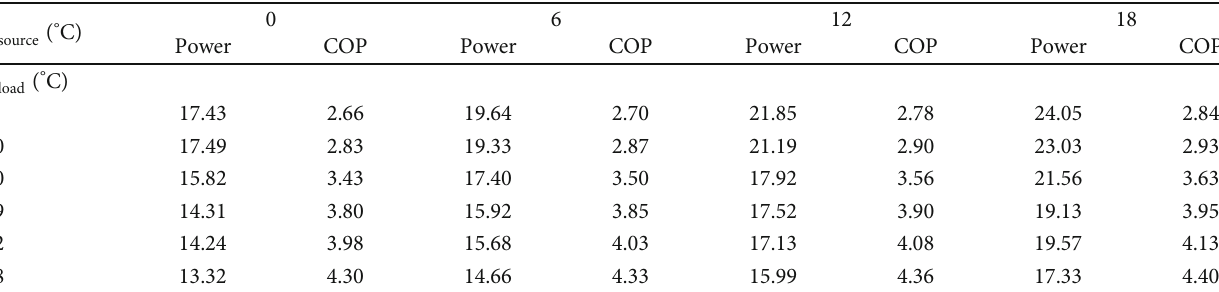
(a) Cooling characteristics of the heat pump